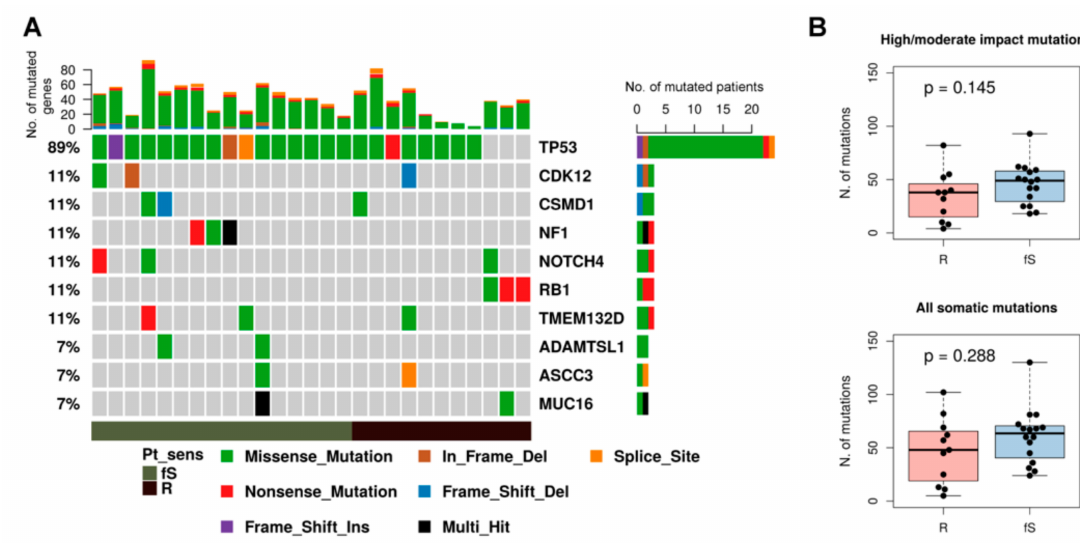
Figure 1. Mutational spectrum of TCGA-OV27 samples. ( A ) Oncoplot of the top-10 most frequently mutated genes in cytoreduction (R0) patients of the TCGA-OV27 dataset, grouped according to sensitivity class. Each column represents a sample and each row a di ff erent gene. Colored squares show mutated genes, while grey squares show no mutated genes. Di ff erent type of mutations are colored according to the variant type as indicated in the legend at the bottom. Genes annotated as “Multi_Hit” have more than one mutation in the same sample. The barplot at the top shows the number of mutated genes for each patient colored according to the mutation type. The barplot on the right reports the number of mutated patients for each gene, colored according to the mutation type. ( B ) Boxplot showing the tumor mutational load of R and fS samples, calculated both considering only mutations with high / moderate impact (upper panel) or all somatic mutations (lower panel). P -value was calculated by Wilcoxon rank-sum